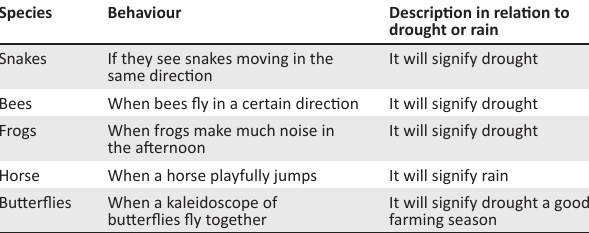
TABLE 2: Behaviour of different species as a sign of drought and